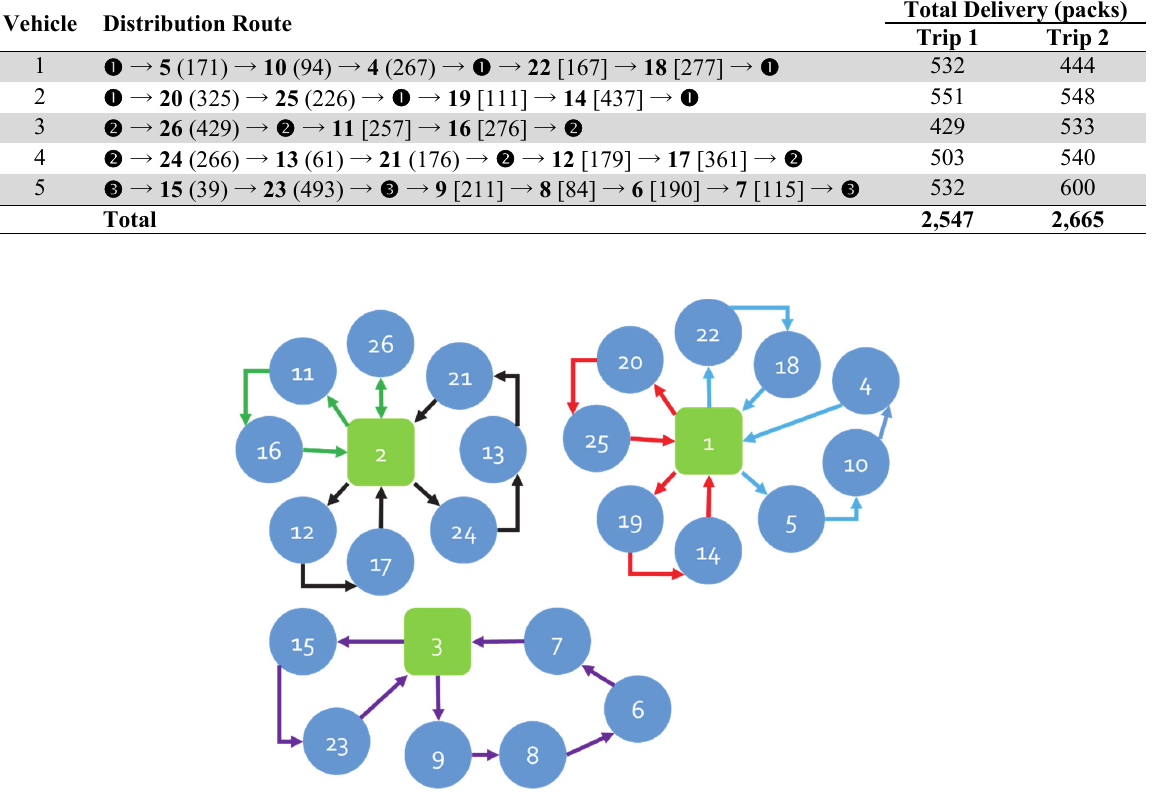
Fig. 3. Distribution route of period